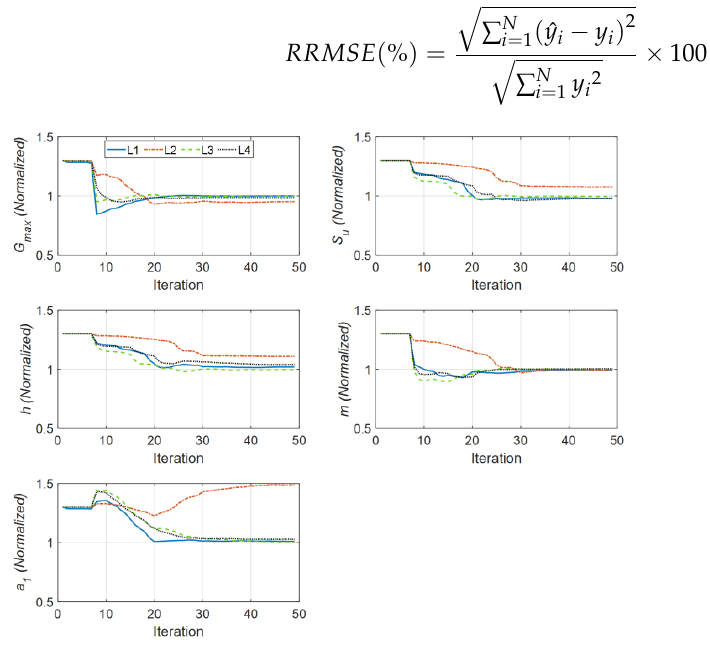
Figure 6. Identified parameters in Case Study 1 (normalized by the corresponding true values).